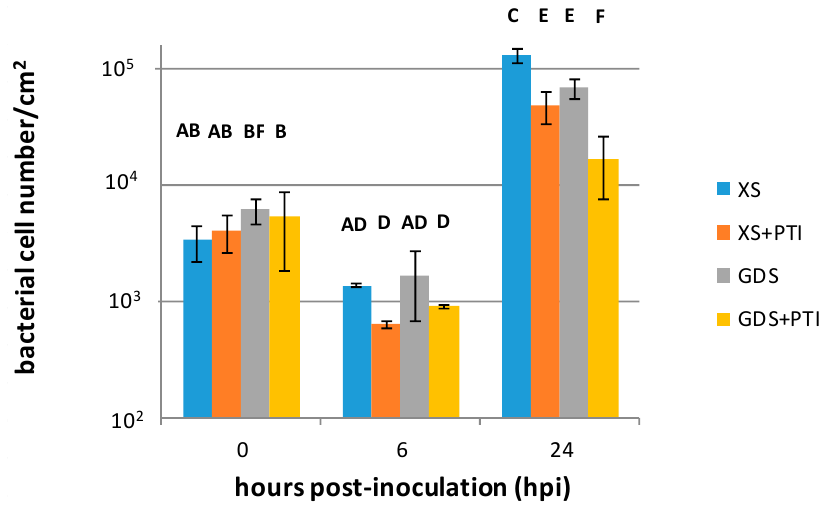
Figure 1. Number of X. euvesicatoria cells in pepper leaves as affected by resistance mechanisms. X. euvesicatoria was injected at 10 6 cells mL − 1 into pepper leaves at the 0 time point. PTI was initiated 24 h before X. euvesicatoria inoculation by injecting the same leaves with heat-killed P. syringae 61 hrcC . Leaf samples were taken at the indicated time points after X. euvesicatoria infections, and the bacterial cell number was determined by the plate-count technique. Three biological replicates were performed, and similar patterns of population dynamics were obtained. Error bars represent mean ± standard deviations of three replicates of a representative experiment. The letters above the columns indicate significantly different groups. XS: susceptible plant, GDS: gds gene-carrying resistant plant, +PTI: PTI activated in the plant before X. euvesicatoria inoculation.